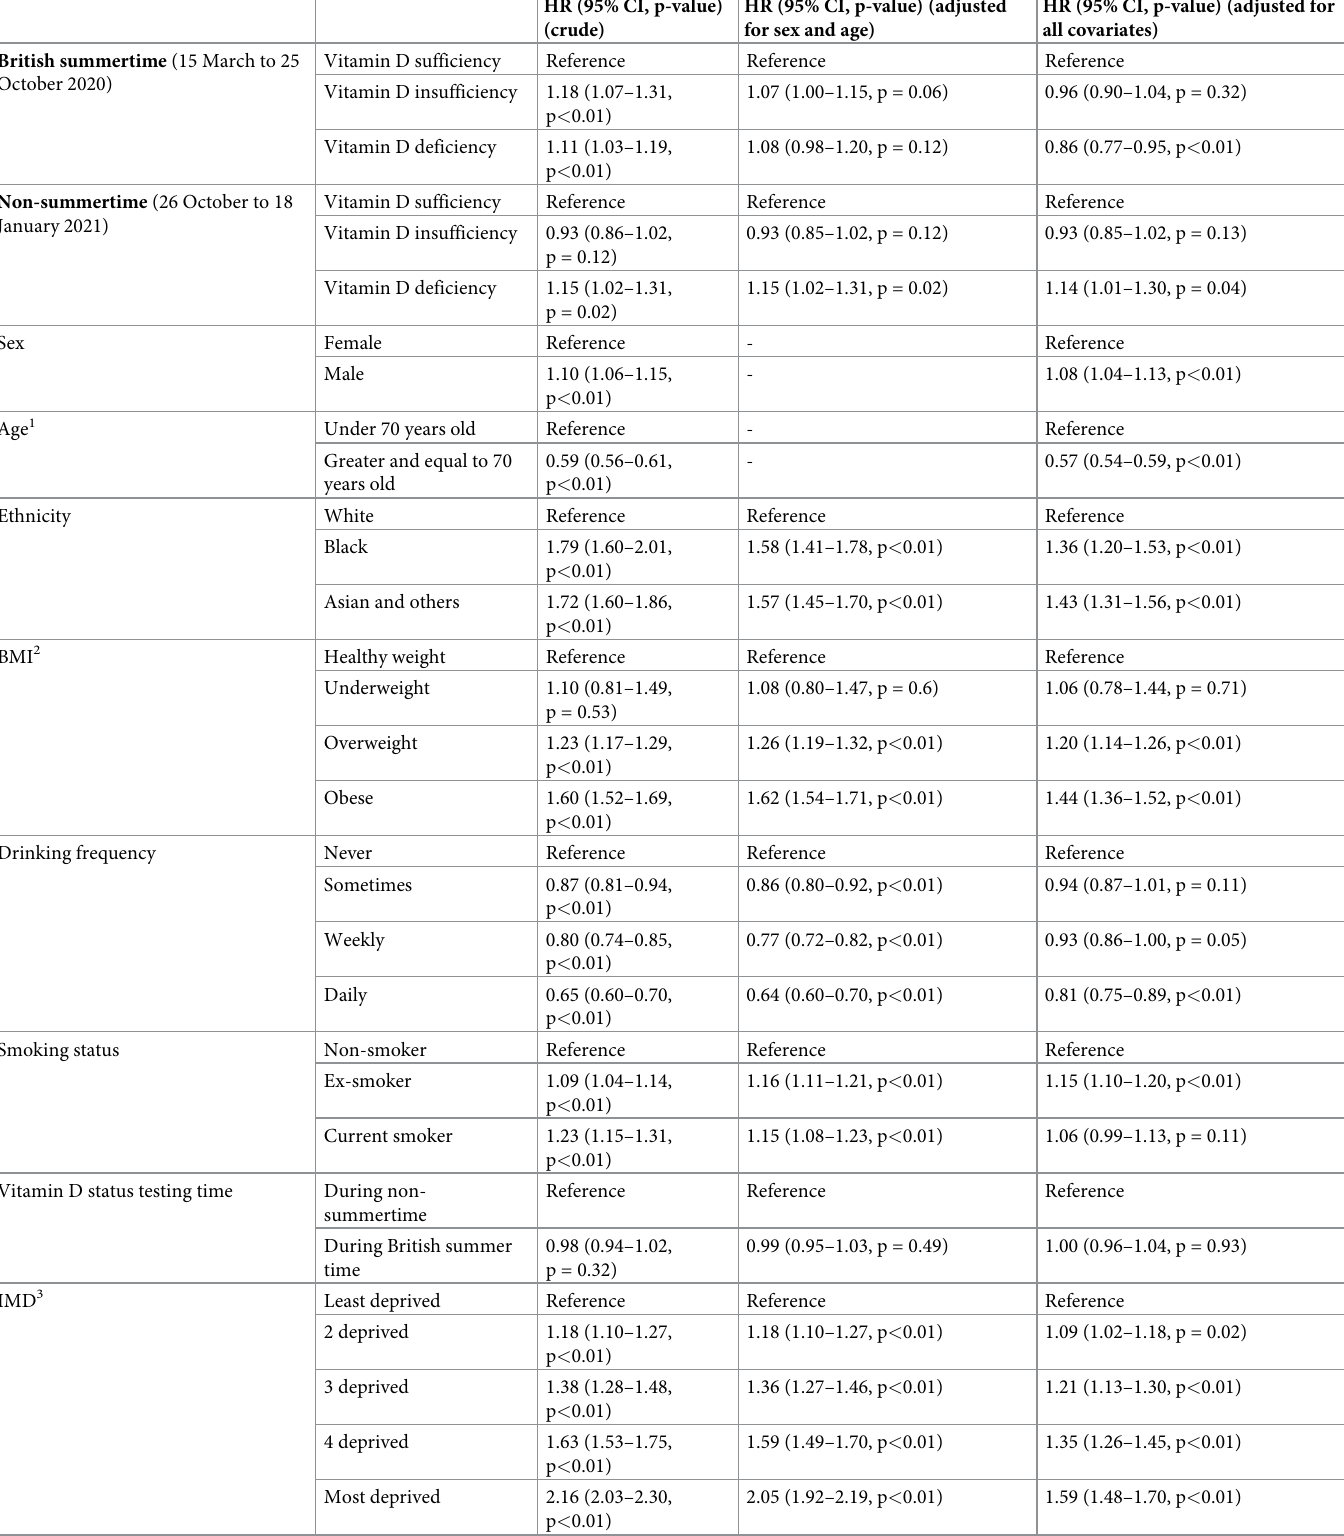
Table 3. The association between vitamin D status and diagnosis of